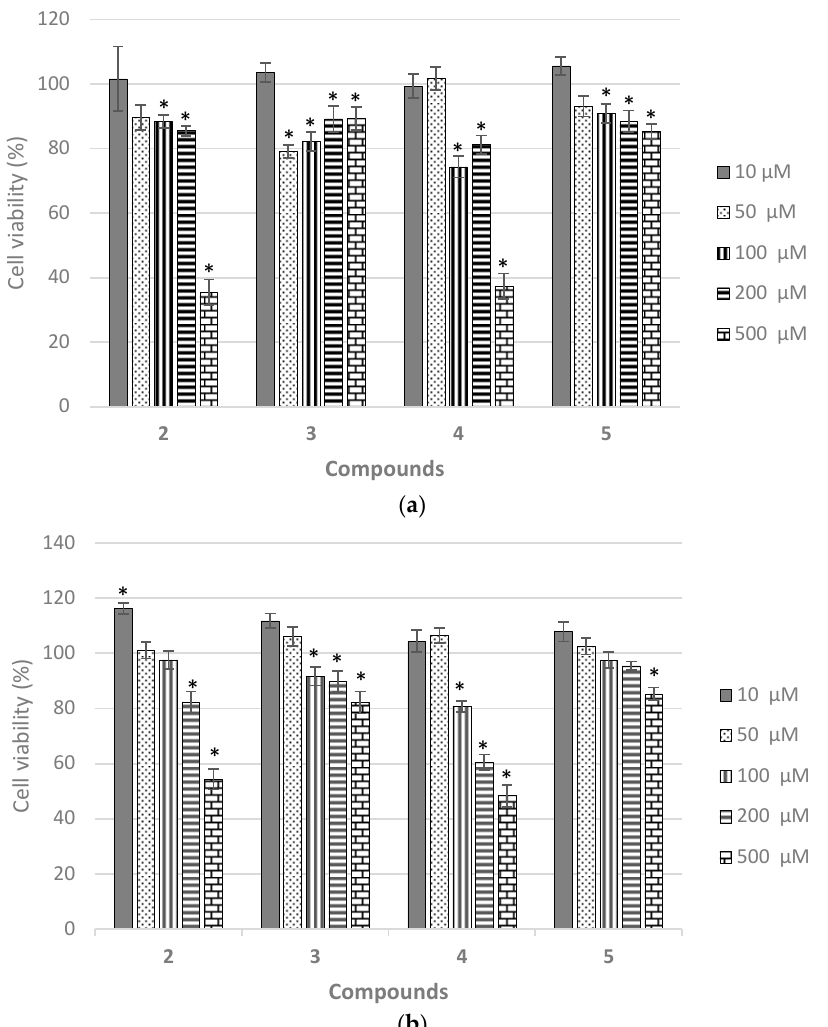
Figure 13. Cell viability of HeLa ( a ) and MCF-7 ( b ) cells treated with peptides 2 – 5 for 72 h in the range of concentration from 10 μ M to 500 μ M and assessed by the CellTiter 96 ® AQueous. One Solution Cell Proliferation Assay. Cell viability (%) was expressed as percentage of treated cells versus control cells. and the data from three individual experiments were expressed as the means (n = 5) ± S.D. * significant difference was considered at a p value < 0.05.